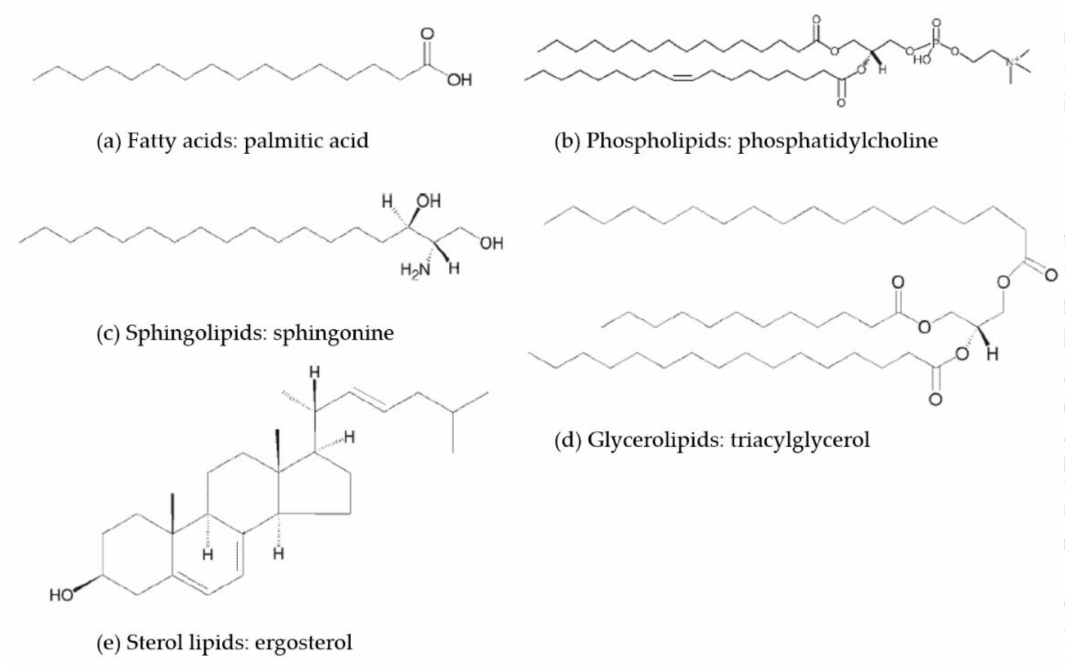
Figure 1. Representative structure of ( a ) fatty acids, ( b ) phospholipids, ( c ) sphingolipids, ( d ) glycerolipids, and ( e ) sterol lipids. This figure is adapted and modified from Ref.